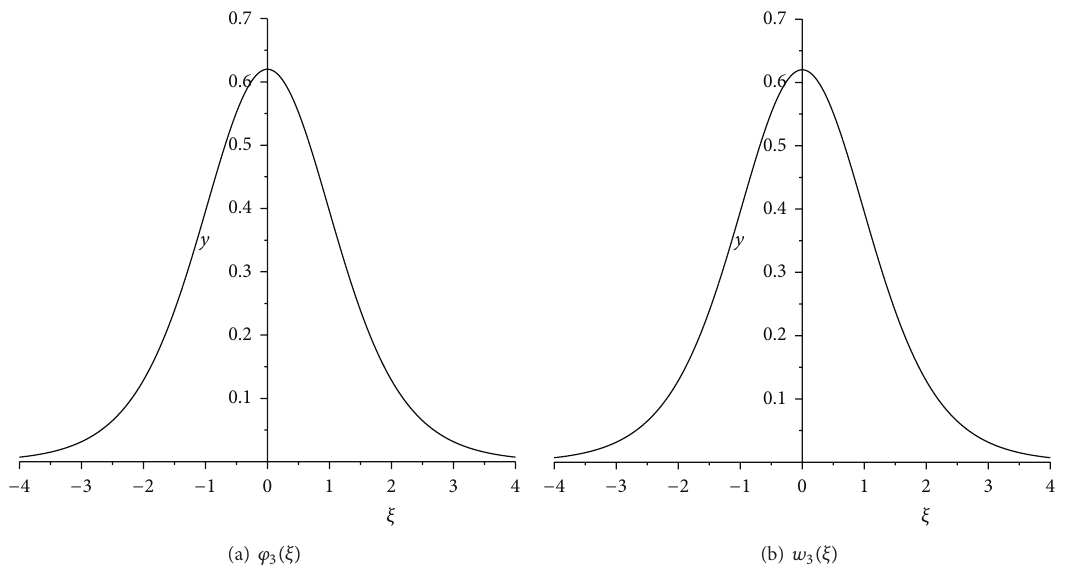
Figure 6: The solitary wave of the system (11) and the system (3) when 2√𝑘𝑐 < 𝑟 < 4√3𝑘𝑐/3 , 𝑘 > 0 , 𝑐 > 0 , and Δ ≥ 0